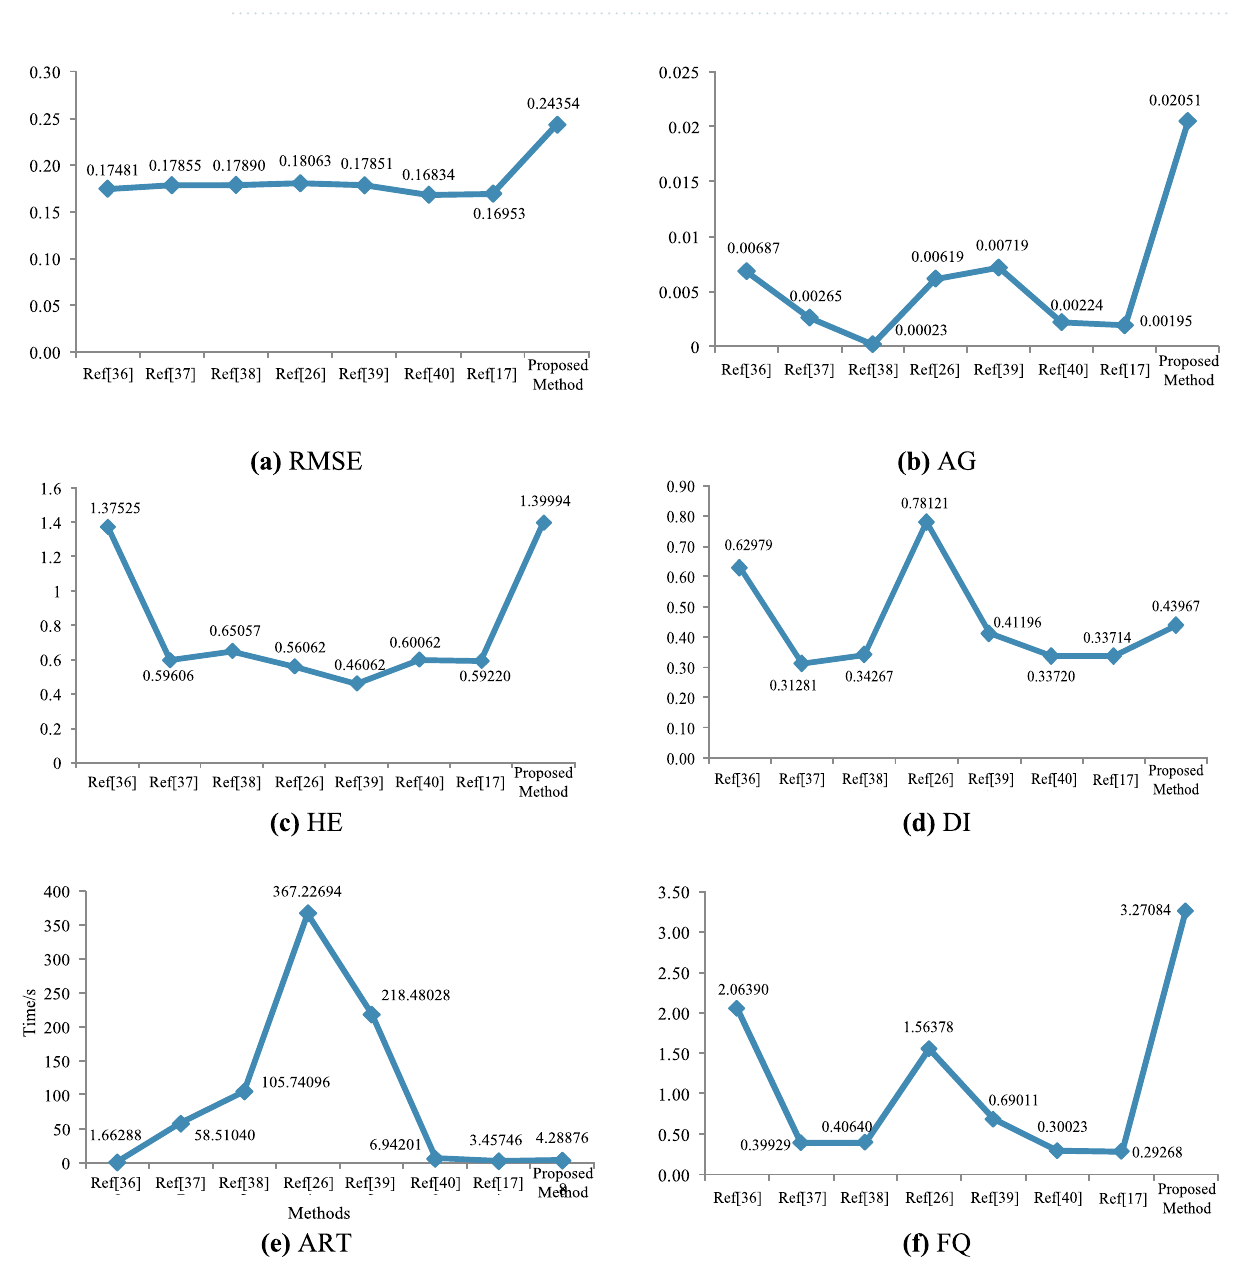
Figure 8. Broken-line graphs of evaluation